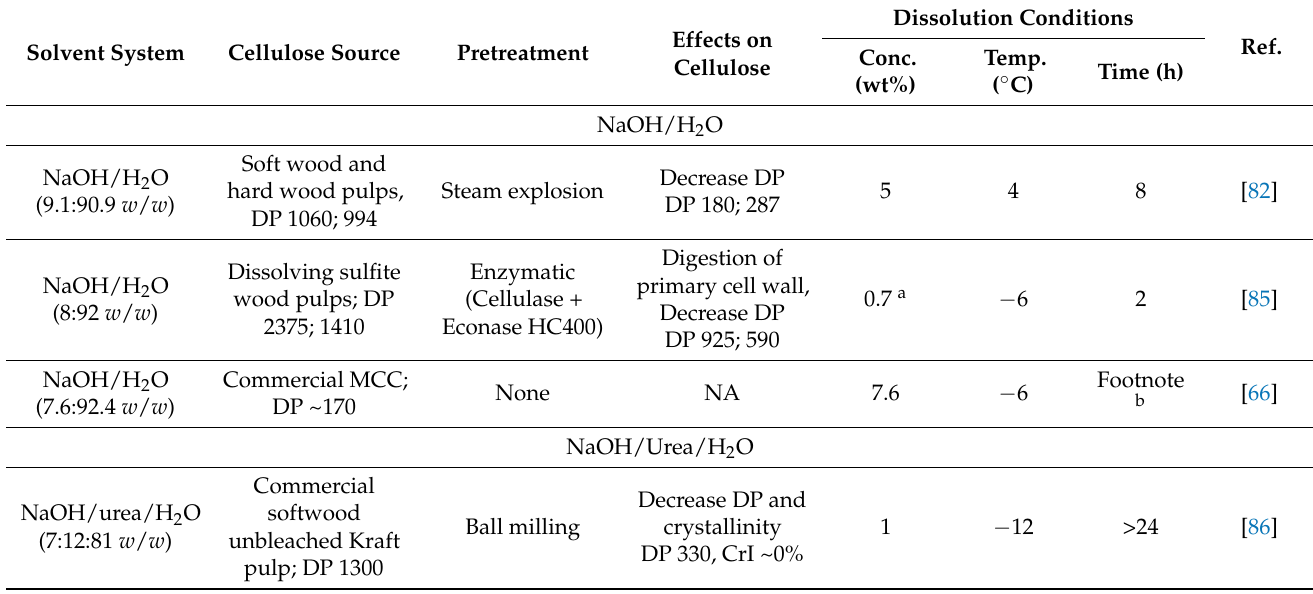
Table 1. Representative examples of cellulose dissolution in NaOH-based